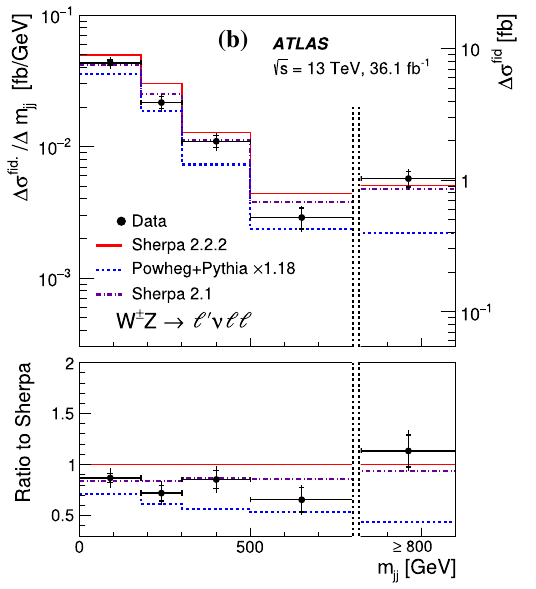
(redline), Powheg+Pythia (dashedblueline)and Sherpa 2.1(dotted- dashed violet line). The right vertical axis refers to the last cross-section point, separated from the others by vertical dashed lines, as this last bin